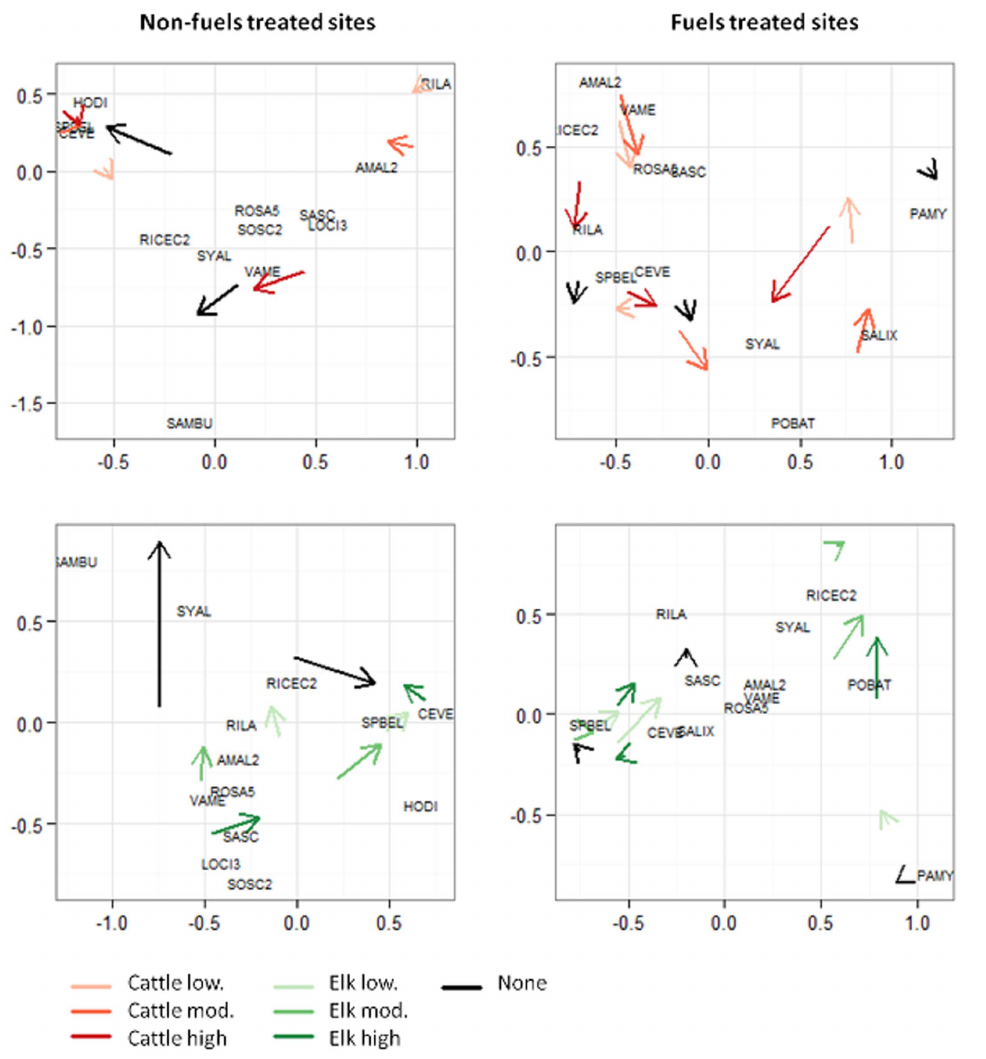
Figure 3. Multidimensional scaling showing change in shrub composition from the year prior to browsing initiation to six years after at fuels treated and non-fuels treated sites. The compositional trajectories of paddocks browsed by cattle and elk at three levels of browsing pressure (low, mod., high) are shown with red and green arrows indicating their pre-treatment and post-treatment composition respectively. Compositional trajectories of un-browsed paddocks (none) are shown with a black arrow. The role of individual shrub species in driving the compositional trajectories is indicated by the location of each species on the plots. Shrub species included where they occur are Arctostaphylos uva-ursi (ARUV), Vaccinium membranaceum (VAME), Vaccinium scoparium (VASC), Rosa spp. (ROSA5), Symphoricarpos albus (SYAL), Spiraea betulifolia lucida (SPBEL), Linnaea borealis (LIBO3), Ribes viscosissimum (RIVI3), Ribes lacustre (RILA), Rubus spp. (RUBUS), Amelanchier alnifolia (AMAL2), Crataegus douglasii (CRDO2), Ceanothus velutinus (CEVE), Salix spp. (SALIX), Holodiscus discolor (HODI), Ribes cereum (RICEC2), Lonicera ciliosa (LOCI3), Salix scouleriana (SASC), Sambucus spp. (SAMBU), Sorbus scopulina (SOSC), Populus balsamifera spp. Trichocarpa (POBAT), and Paxistima myrsinites (PAMY).